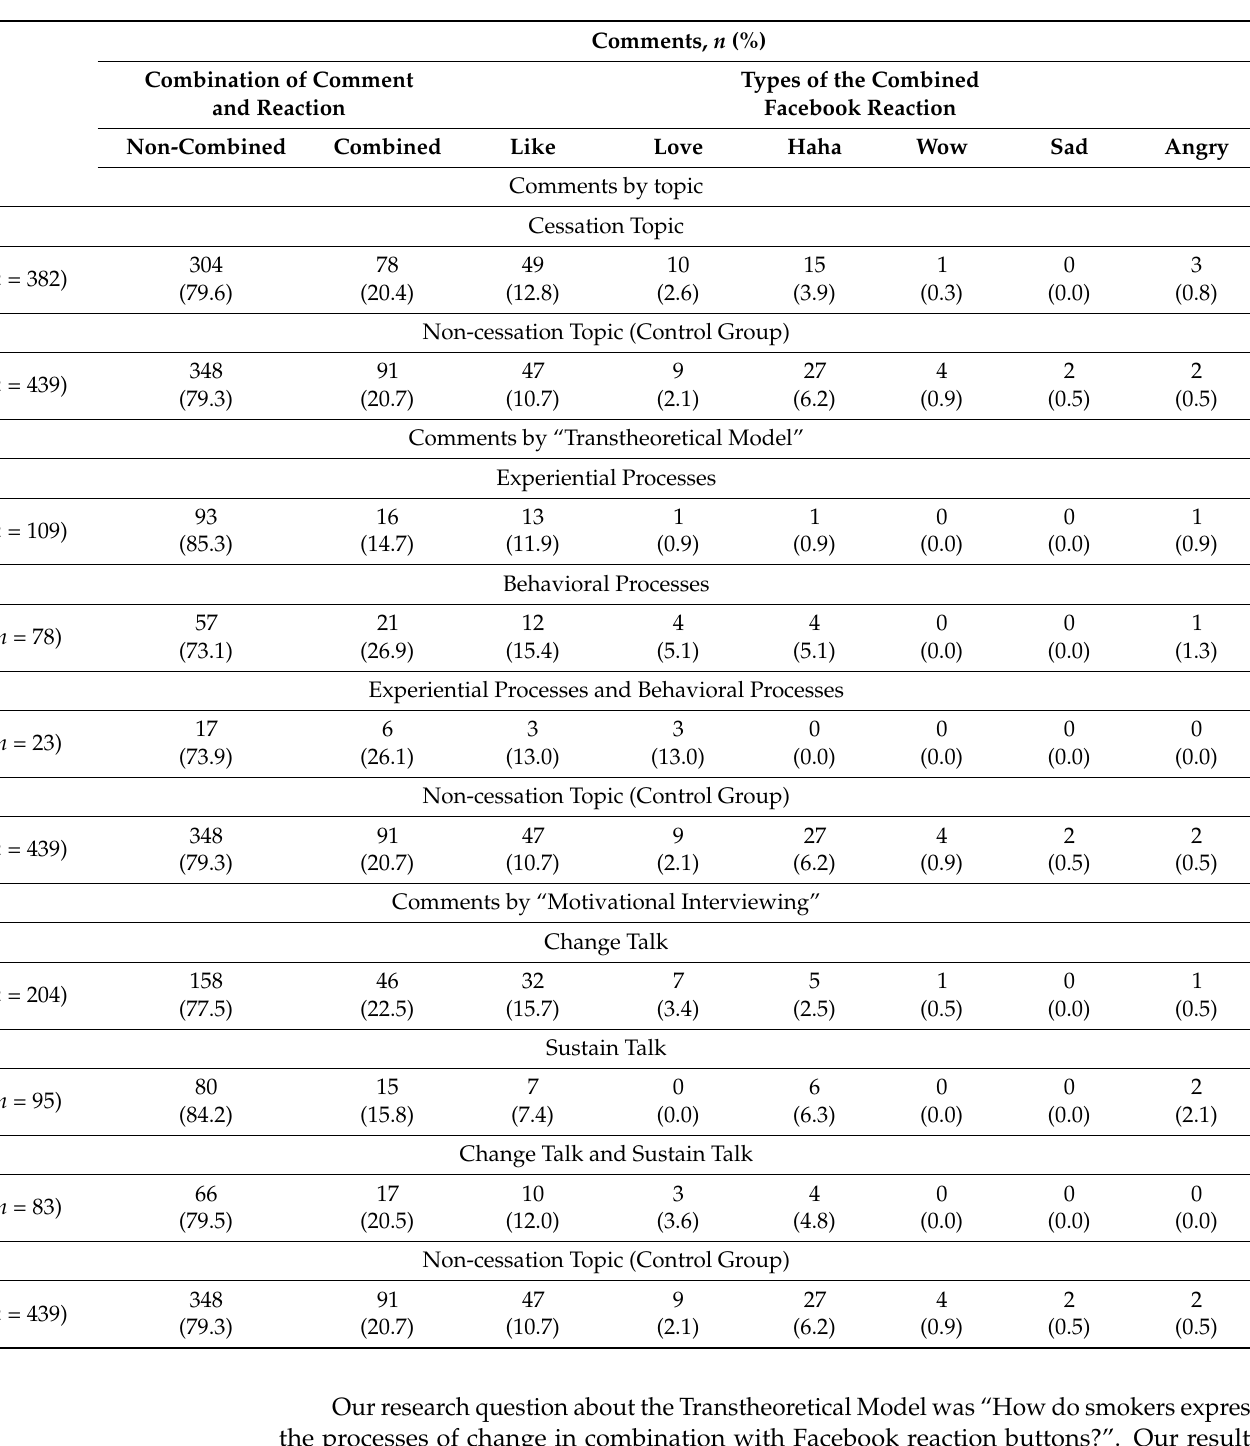
Table 1. The number ( n ) and the distribution (%) of comments in different categories according to the Transtheoretical Model and Motivational Interviewing ( n =